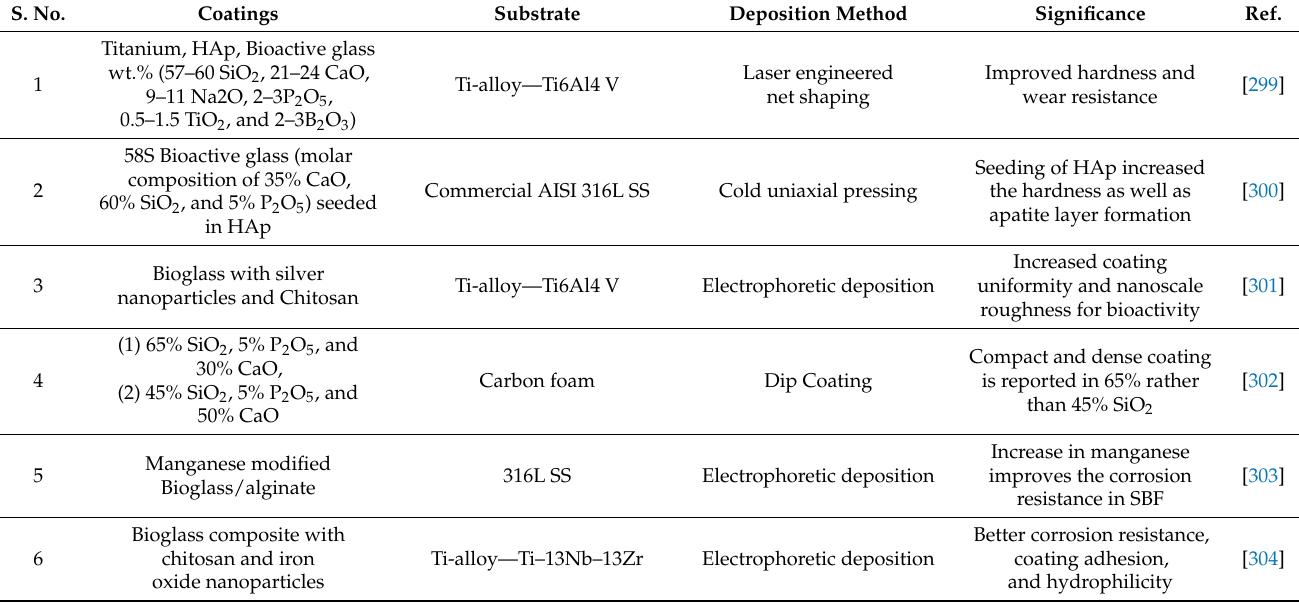
Table 8. Composition, the substrate used, coating process, and their salient features of bioactive